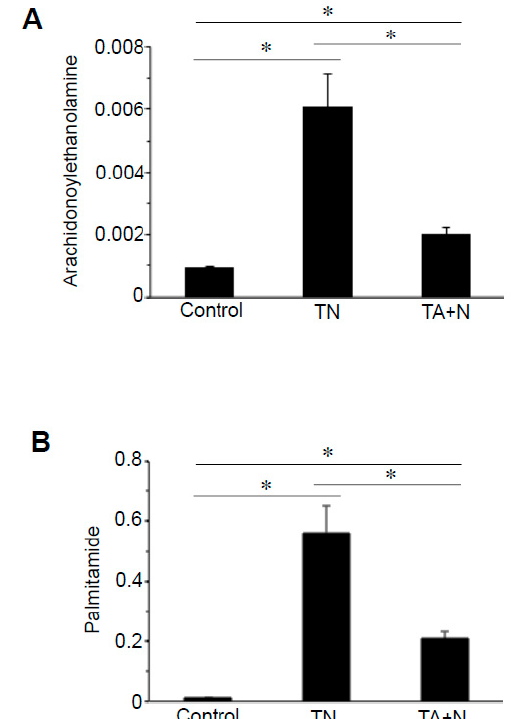
Figure 3. TN is an efficient activator of arachidonoylethanolamine and palmitamide upregulation. Human pulmonary artery smooth muscle cells were treated with either TN (100 μ M) or TA (100 μ M) plus niacin (100 μ M) (TA + N) for 10 min. Samples were subjected to metabolomics analysis. ( A ) Arachidonoylethanolamine and ( B ) palmitamide were found to be differentially expressed between TN and TA + N groups. Bar graphs represent the mean ± SEM values of signal intensity. * Values are significantly different from each other at p < 0.05 ( n = 9).